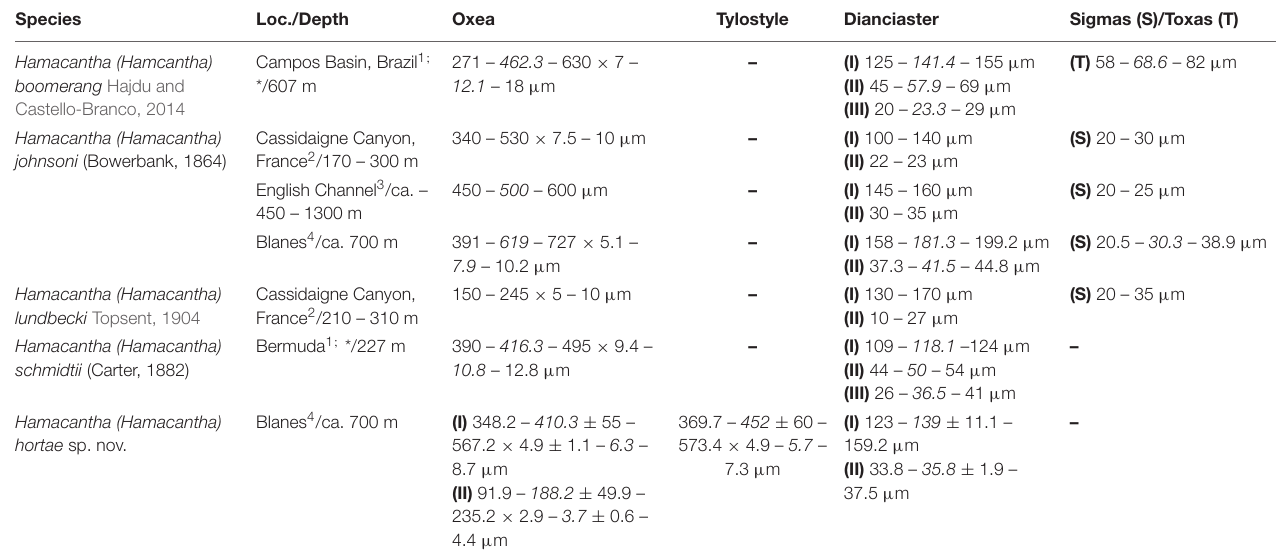
TABLE 3 | Comparative table between the North Atlantic Hamacantha (Hamacantha) species, including the locality (Loc.) and depth of the sample, as well as the measurement of their spicular complement. Species Loc./Depth